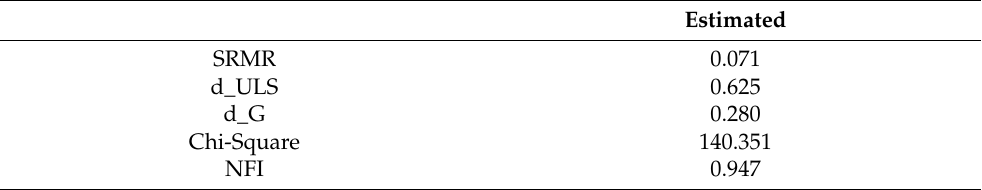
Table 4. Model fit.